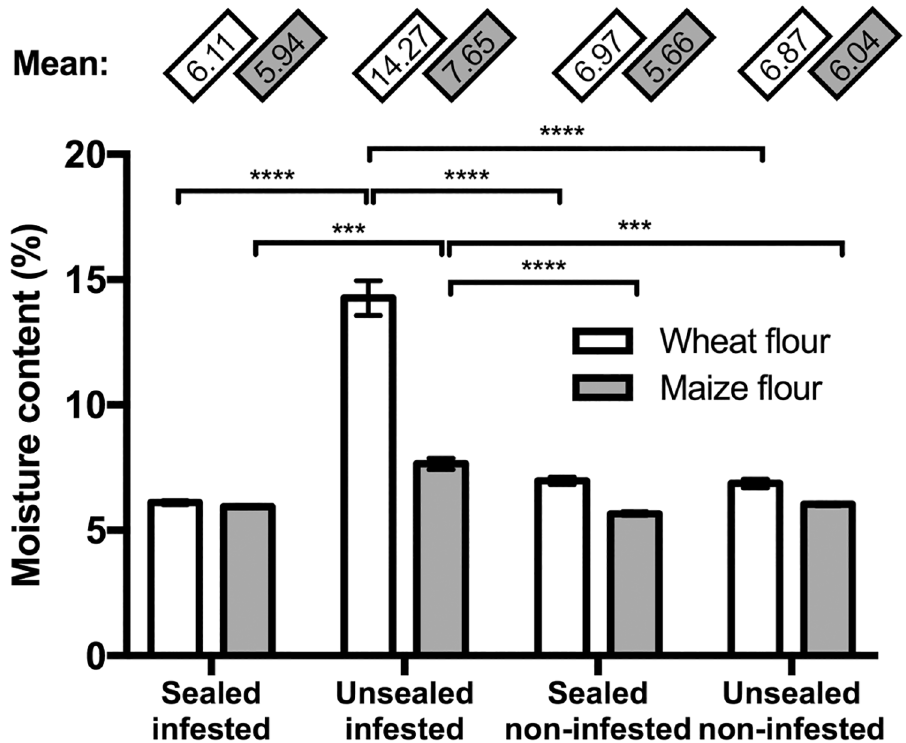
Fig 4. The treatment had a significant effect on the moisture content of the flour. The unsealedinfested treatment showeda highermoisture readingthan the ones within each flour type (Sealedand infestation condition: F (3, 64) = 147.3, P < 0.0001; Flour type: F (1, 64) = 132.5, P < 0.0001). Columnheights represent the mean while the error bars show the standarderror of the mean. “ *** ” and “ **** ”represent P < 0.001 and P < 0.0001,